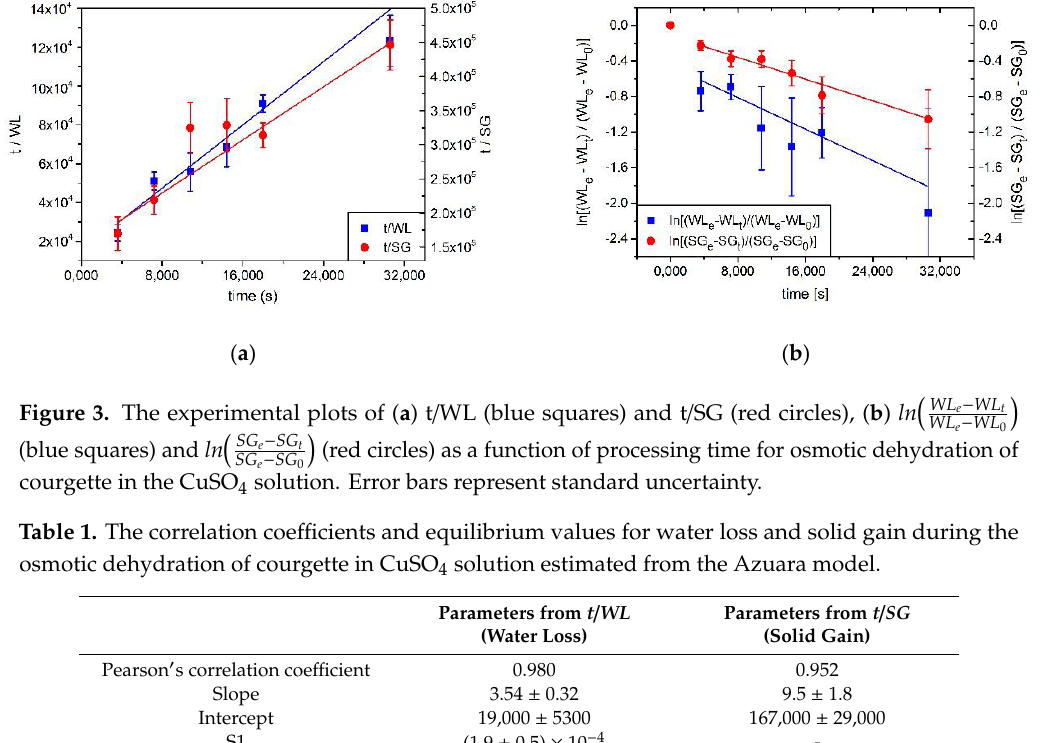
Figure 2. Water loss (blue squares) and solid gain (red circles) versus time during the osmotic dehydration of courgette in the CuSO 4 solution. Error bars represent standard uncertainty.